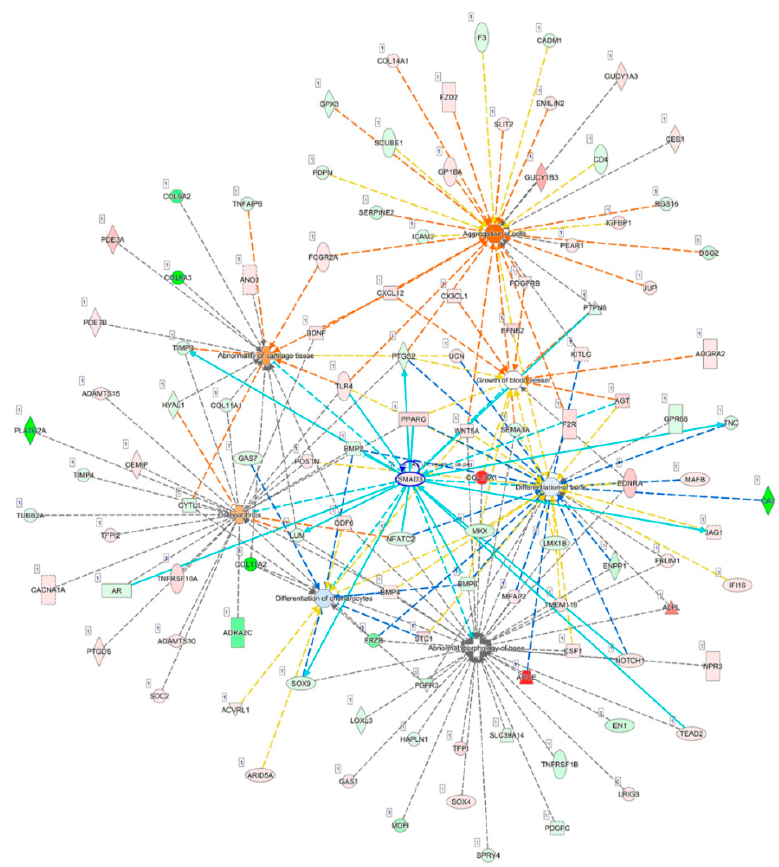
Figure 4. Analysis of interconnections and the merged network of OA-related diseases and functions. The 495 differentially expressed genes identified in OA knee chondrocytes were analyzed in the Ingenuity Pathway Analysis (IPA) software, and diseases and functions related to cellular, tissue and structural changes of cartilage in OA, including osteoarthritis, abnormality of cartilage tissue, differentiation of chondrocytes, growth of blood vessel, and aggregation of cells, were selected to identify target genes involved. SMAD3 was centered to the merged network and interconnected with the molecules of other networks, as indicated in light blue lines, including those in the growth of the blood vessel. WNT5A was involved in aggregation of cells, which was possibly associated with the formation of chondrocyte clusters in OA.